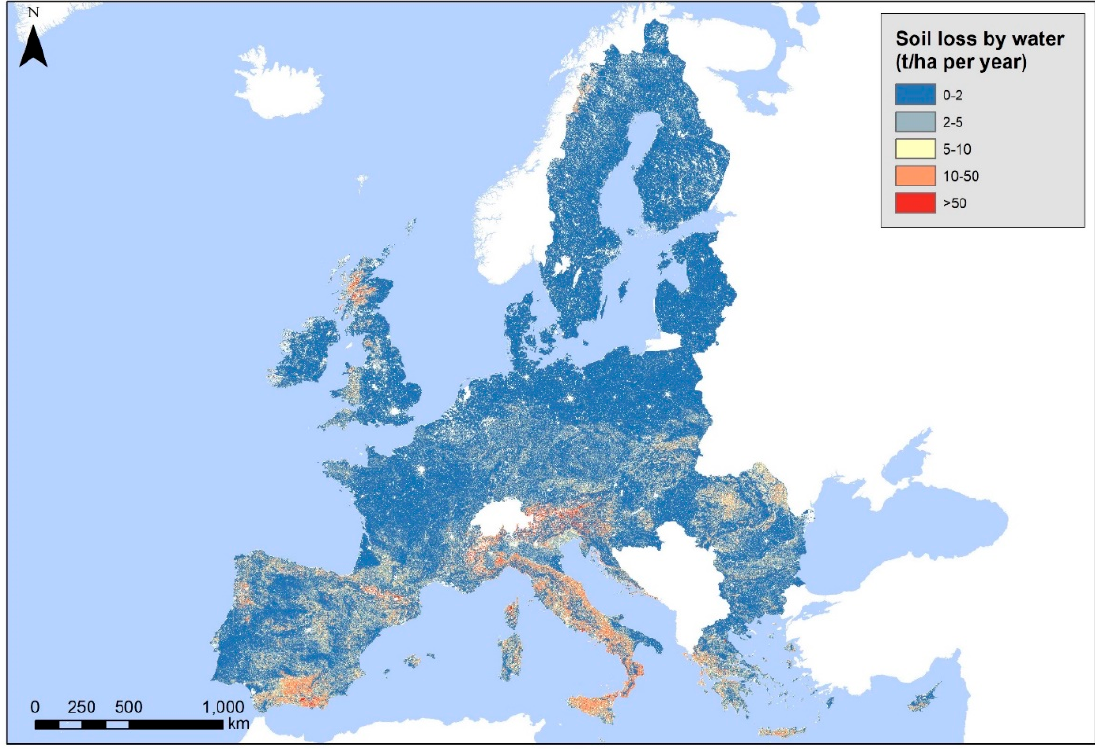
Figure 3. Soil loss (by water) expressed in tons per hectare per year (data source: References [16,35]).